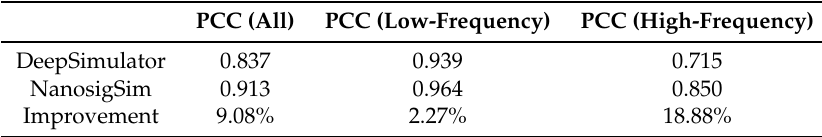
Table 1. PCC comparison between the CWT spectrums of different signals.